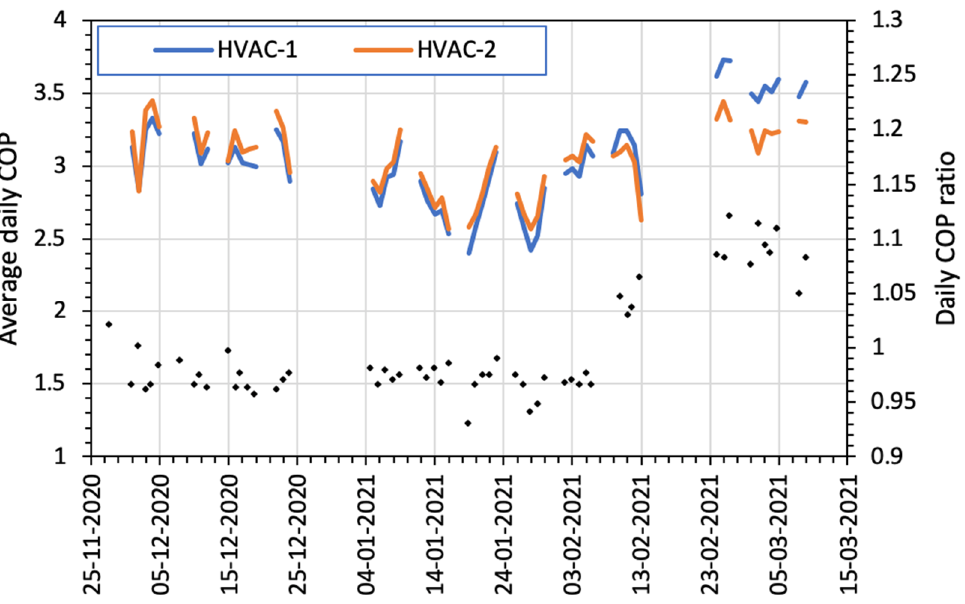
Figure 12. Average daily COP comparison and daily COP ratio between HVAC-1 and HVAC-2 (27